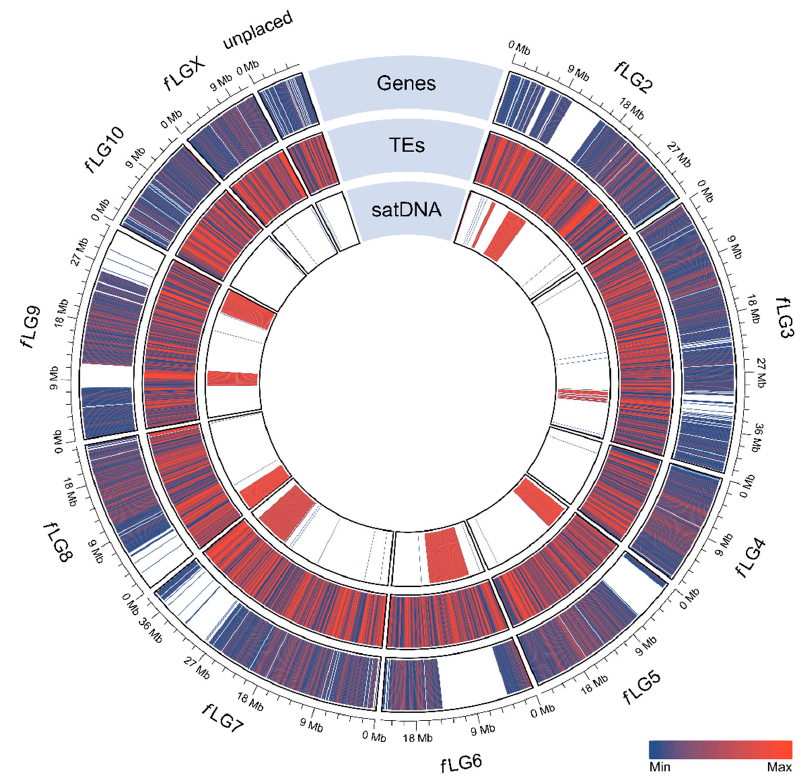
Figure 8. Circular visualization of the T. freemani genome assembly Tfree1.0. The assembly was pro- duced by hifiasm and orientated into ten linkage groups ( f LGs) by using RagTag and the T. casta- neum genome assembly Tcas5.2 as a reference. The tracks represent genes, transposable elements (TEs), and the major satellite DNA (satDNA) distributed along ten chromosomal linkage groups ( f LGs) and the unplaced contigs. Density of annotation distribution is color-coded with blue representing areas with less and red representing areas with more element-rich regions. Visualization was performed with circlize package implemented in R.